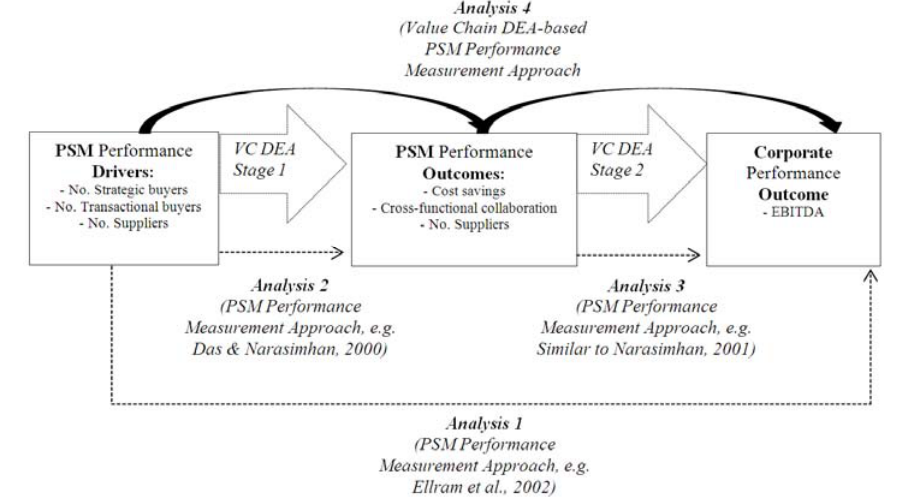
Fig. 3. The PSM performance evaluation framework using DEA Source: Saranga and Moser (2010, p.